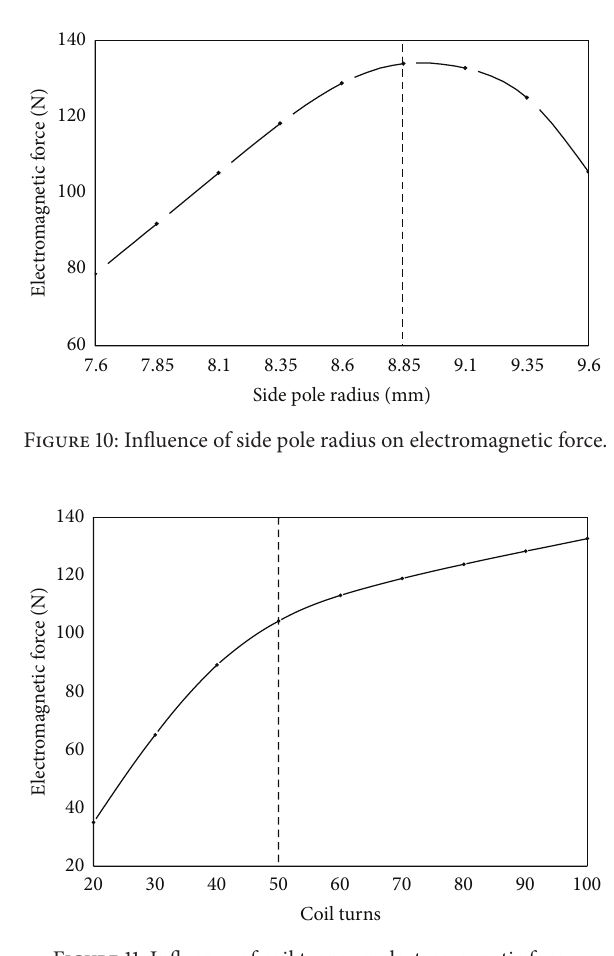
radius main pole gets prematurely saturated which restricts the increase of the main magnetic flux. Similarly, with the increase of side pole radius the effective main pole area becomes large. As a result, the magnetic saturation weakens and electromagnetic force increases. However, when side pole radius is more than 8.85 mm the magnetic flux area of side pole is too small and as a result it gets magnetically saturated. The larger the side pole radius is beyond 8.85 mm, the worse the saturation and electromagnetic force will be. Therefore, when other parameters remain constant, the side pole radius has an optimal size.